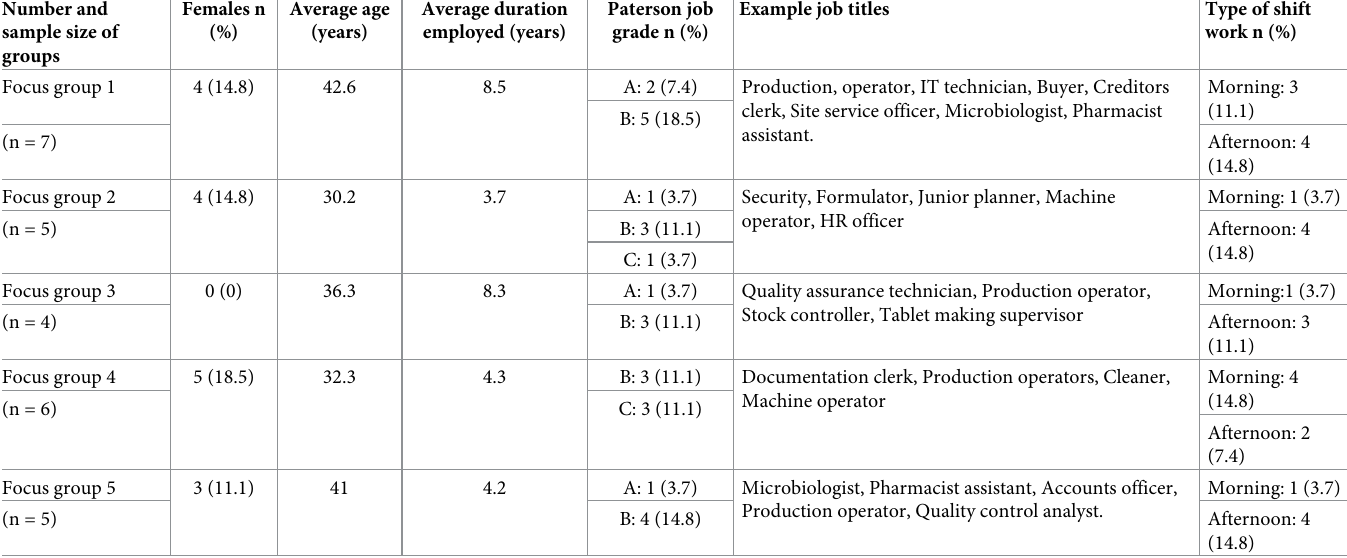
Table 1. Demographic characteristics of participants (n =